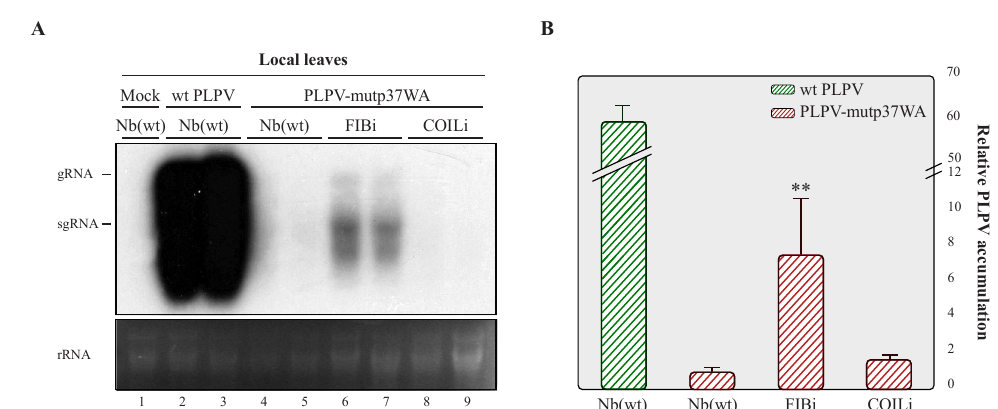
Figure 4. Accumulation of PLPV-mutp37GA in lines of N. benthamiana with downregulated fibrillarin or coilin content. The PLPV-mutp37WA was inoculated in wt, FIBi, and COILi N. benthamiana lines. Northern blot ( A ) and RT-qPCR ( B ) analyses of local leaves collected at 7 dpi. For Northern blot ( A ), a PLPV- specific riboprobe was employed. Positions of the PLPV genomic (g) and subgenomic (sg) RNAs are indicated at the left of the blot, and ethidium bromide staining of rRNAs is included below the blot as loading control. Two distinct samples are shown for each virus–plant line combination. A mock-inoculated plant was included as negative control. In ( B ), the bars depict the standard deviation from three independent biological replicates. The statistical significance was checked using a paired t -test (** p < 0.01).